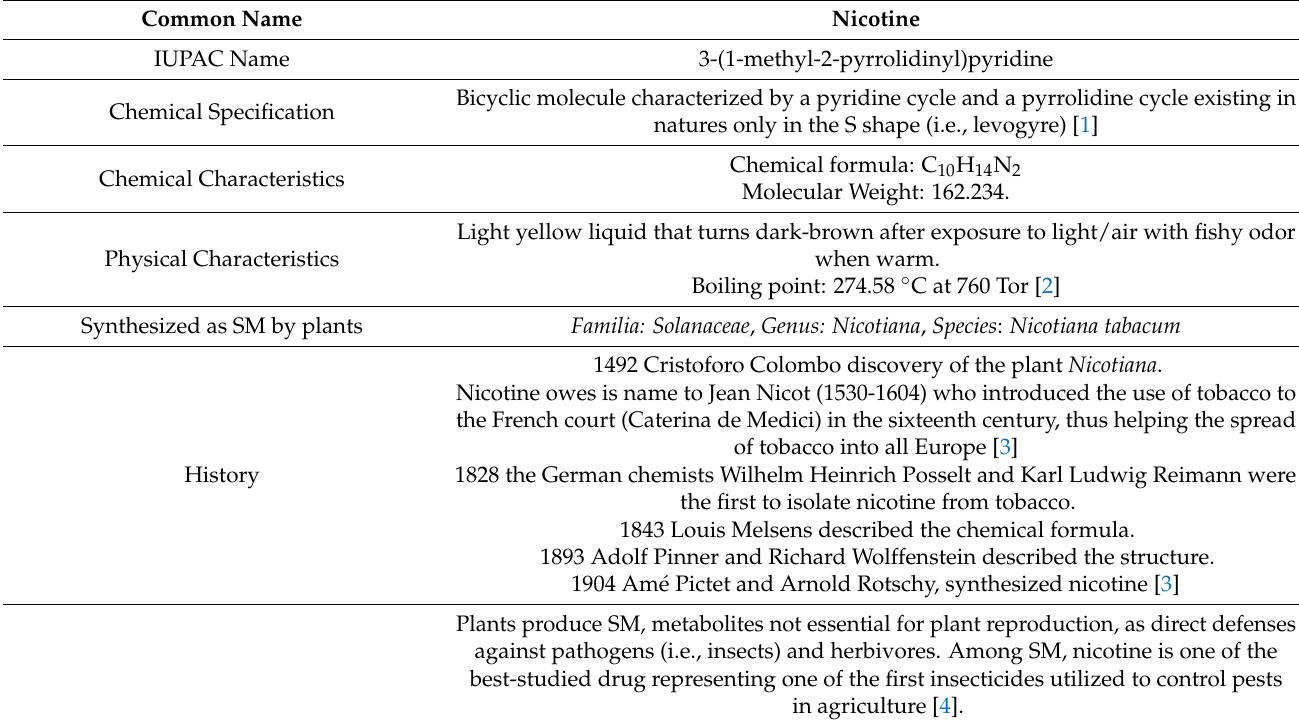
Table 1. Nicotine: Chemical, physical, biological characteristics and historical